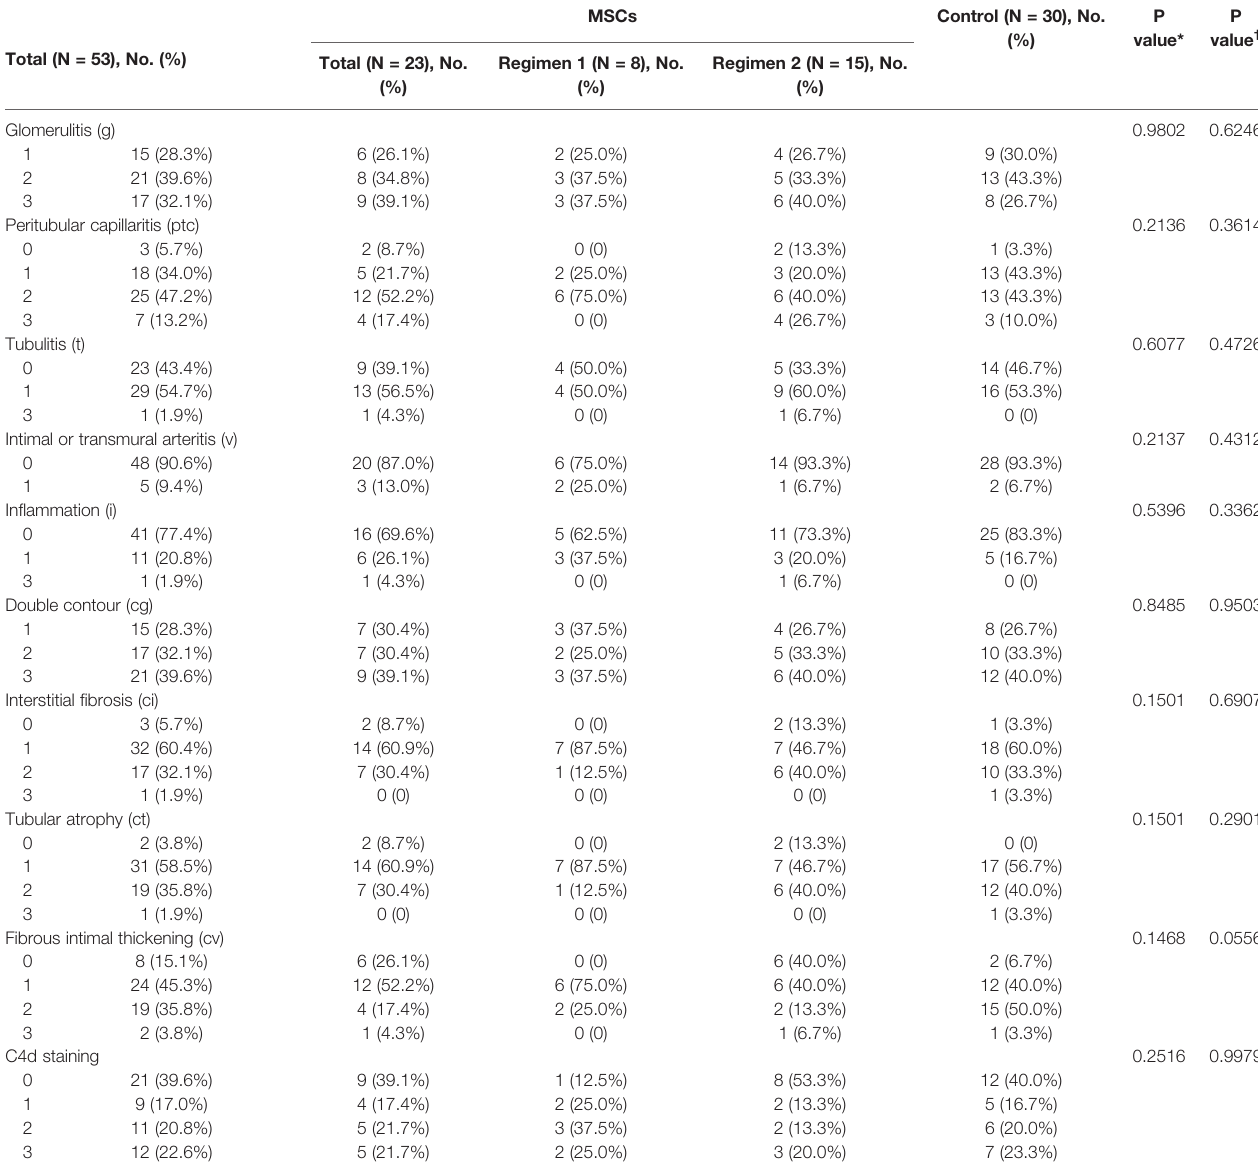
MSCs Control (N = 30), No.